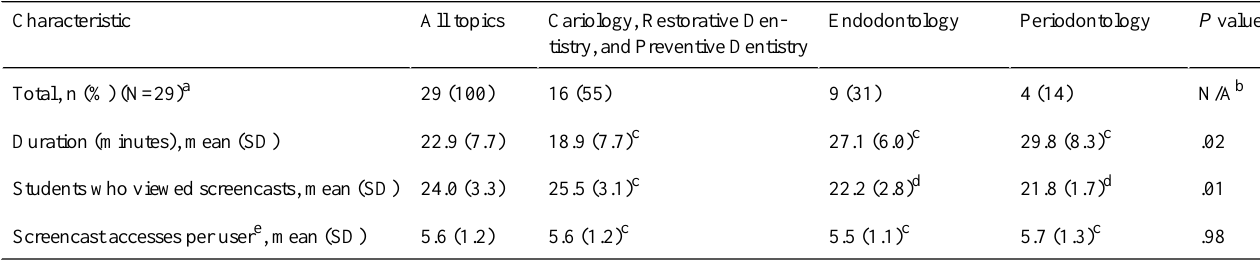
Table 1. Characteristics of screencasts uploaded for each topic.